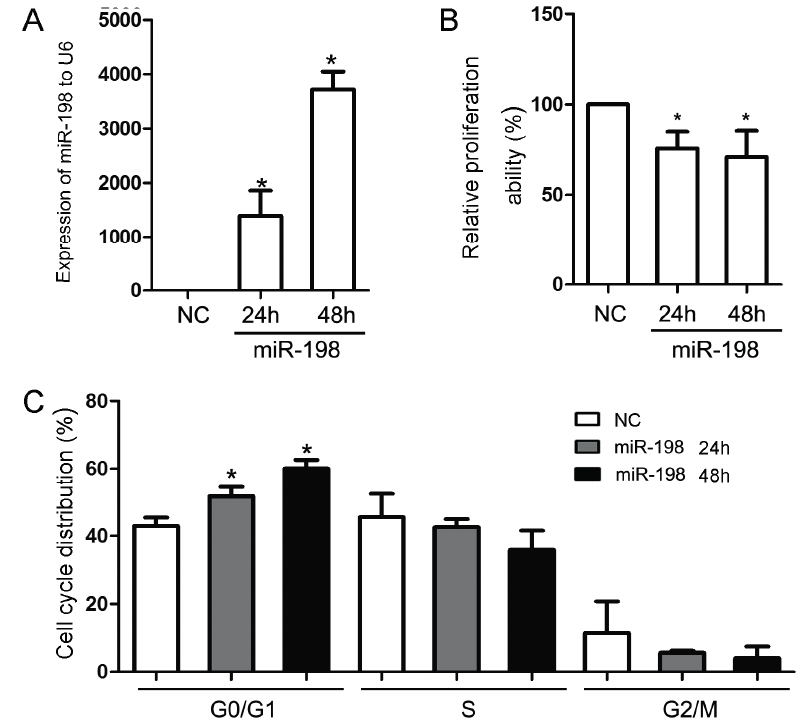
Figure 1. MiR-198 transfection inhibited HaCaT cell proliferation by cell cycle arrest in G1 phase. ( A ) MiR-198 mimic transfection led to a significantly elevated miR-198 expression in HaCaT cells both at 24 h (1390.00 ± 468.20 folds) and 48 h (3718.00 ± 329.40 folds); ( B ) Cell viability analysis showed that miR-198 mimic transfection inhibited HaCaT cell proliferation at 24 h (75.77% ± 9.14%) and 48 h (70.94% ± 14.54%); ( C ) Flow CytoMeter analysis showed the effect of miR-198 transfection on cell cycle progression, and G1 phase arrest was obvious at 24 h (51.71% ± 2.81%) and 48 h (60.07% ± 2.54%) after the transfection when compared with the negative control (42.98% ± 2.48%). (NC, negative control. * Compared with NC, p <